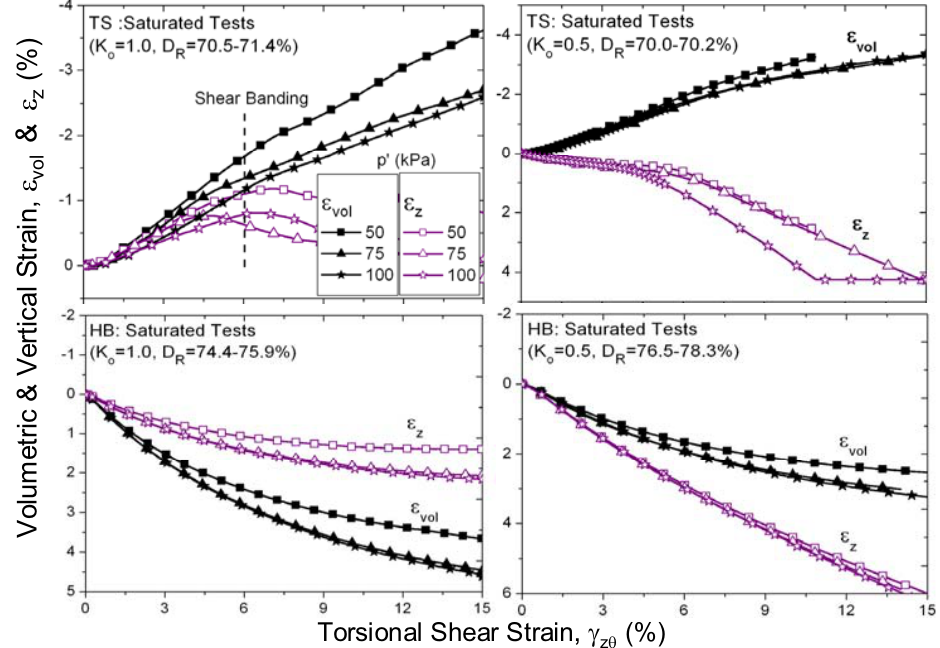
Figure 14. Shear strain and vertical strain relationships during torsional shear. 3